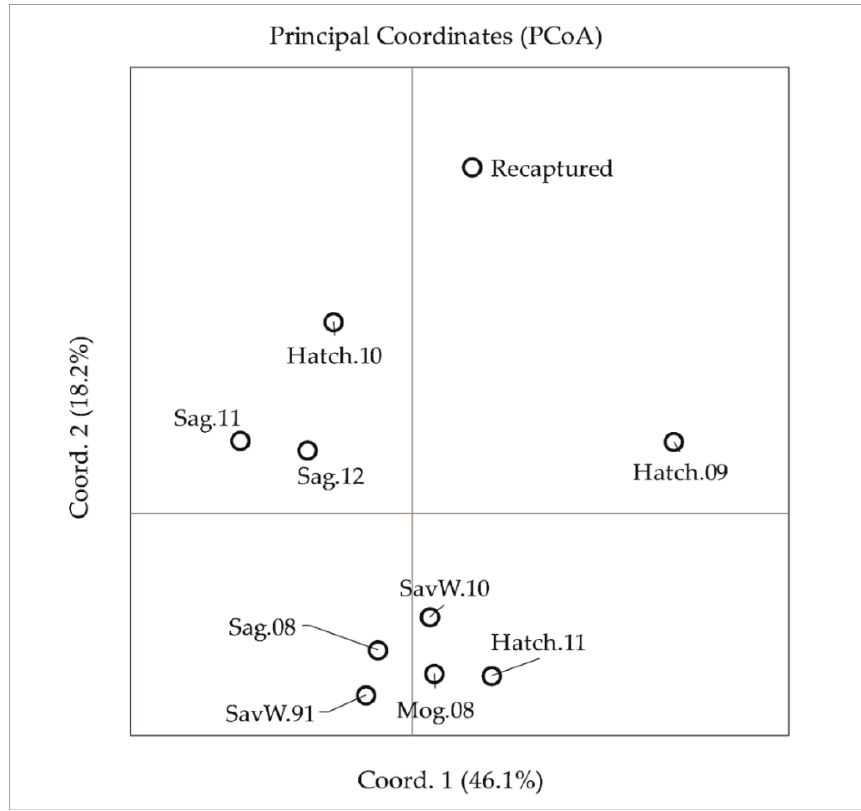
Figure 5. Plot of principal coordinate analysis (PCoA) based on pairwise population matrix of mean population codom genotypic genetic distance of the 10 analyzed samples. Proportion of variation explained by components Coord. 1 and Coord.2.